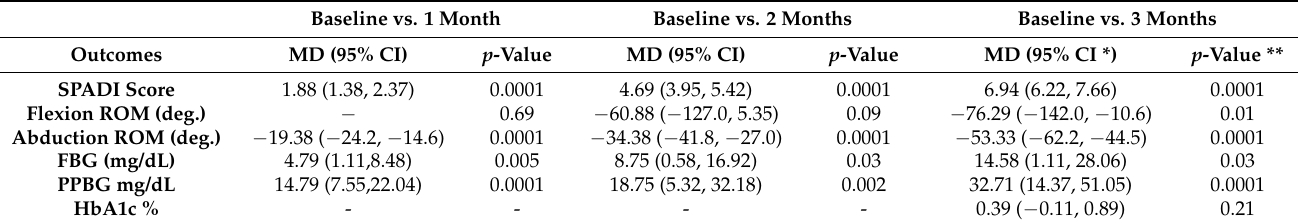
Table 4. Pairwise Comparisons for Group B Pretreatment, after 1 Month, 2 Months and 3 Months *. Baseline vs. 1 Month Baseline vs. 2 Months Baseline vs. 3